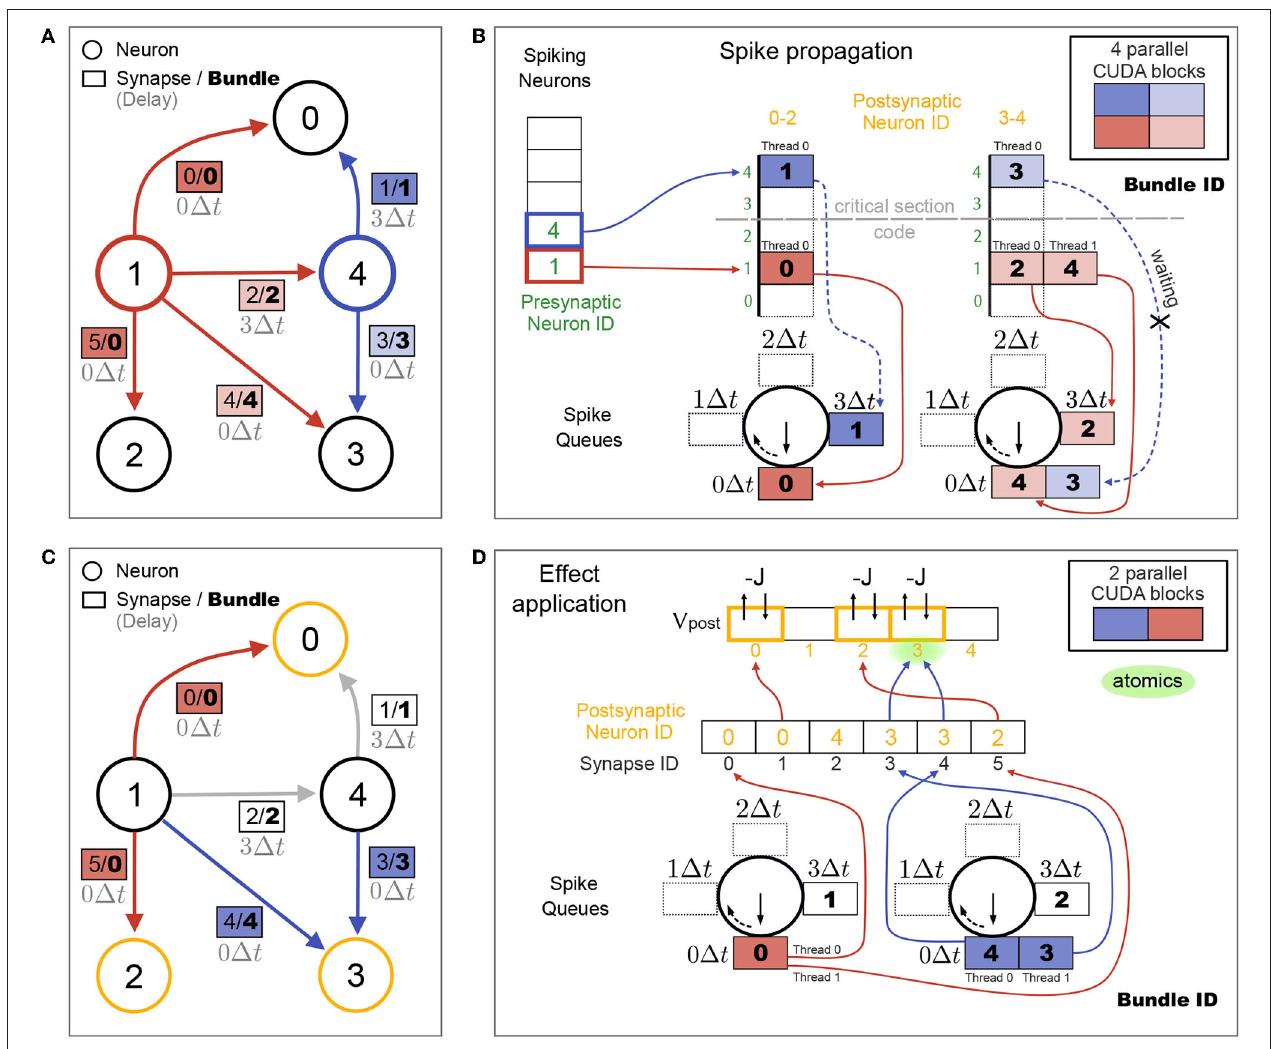
FIGURE 4 | Spike propagation and synaptic effect application for synapses with heterogeneous delays. (A) Same connectivity as shown in Figure 3A , but with heterogeneous delays d ij from neuron j to i . Neurons spiking in the current time step and their outgoing synapses are colored. Colors of synapse labels correspond to the parallelization over CUDA blocks during spike propagation in (B). Bundles group together synapses with same presynaptic neuron, postsynaptic partition as shown in (B) and delay value. All bundles for the same presynaptic neuron and postsynaptic partition define a bundle group (same color), each with a different delay. In this toy example, only bundle 0 has two synapses (0 and 5), the other bundles contain only one synapse. Additionally only the bright red bundle group consists of two bundles (2 and 4), while the other bundle groups contain only one bundle. (B) Spike propagation step. Bundles for all spiking neurons are sorted into spike queues based on their delay value and postsynaptic partition. Maximal delay in (A) is d 0,4 = 3 1 t , requiring 4 spike queues per partition. Each of the 4 CUDA